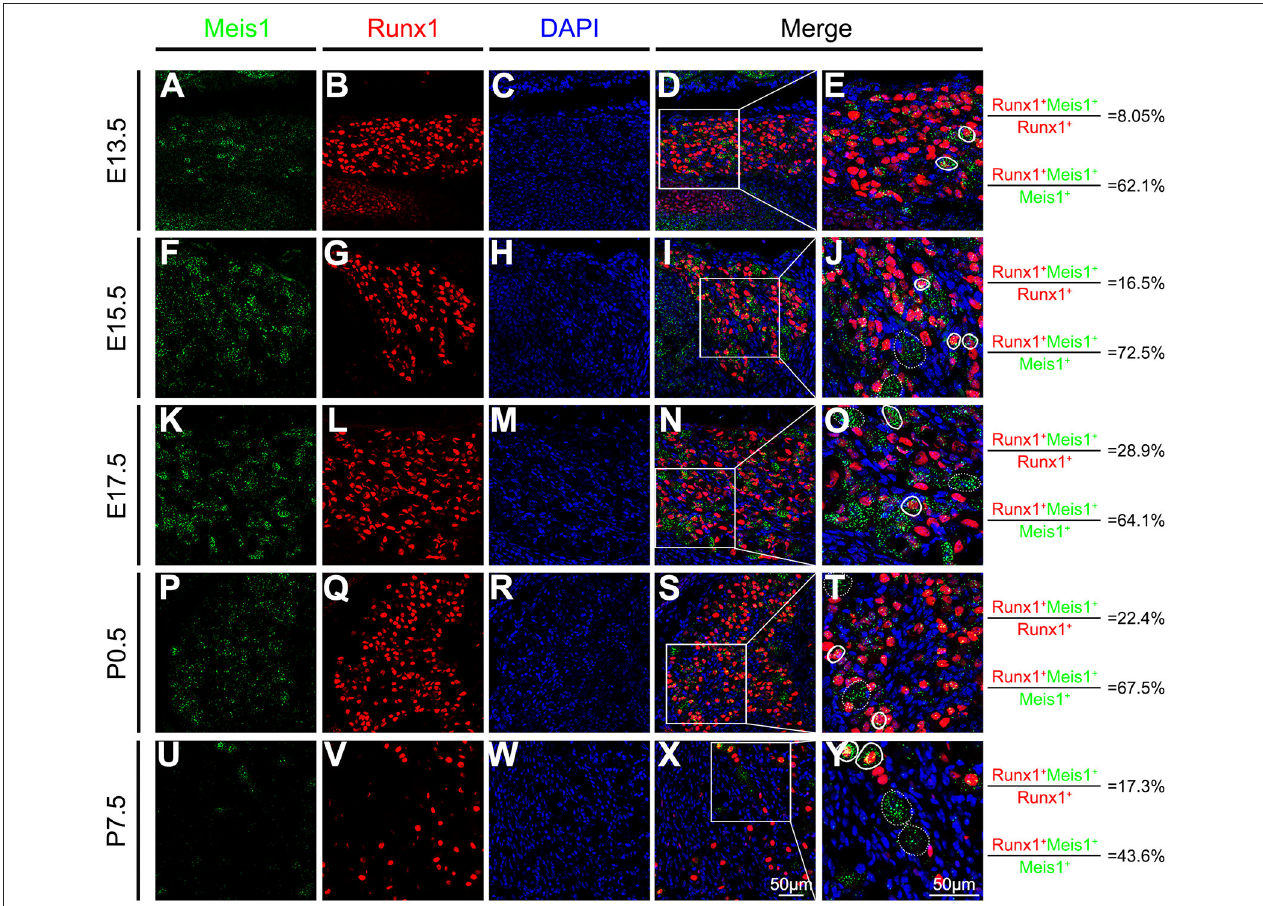
FIGURE 1 | Meis1 expression pattern in the DRG at different stages. Representative images of lumbar DRG sections costained with an antibody against the Runx1 protein (red) and Meis1 mRNA (green) in wild-type animals at E13.5 (A–E) , E15.5 (F–J) , E17.5 (K–O) , P0.5 (P–T) , and P7.5 (U–Y) . Note that 8.05% (379/4711), 16.5% (367/2219), 28.9% (954/3306), 22.4% (684/3052) and 17.3% (370/2142) of Runx1 + neurons coexpressed Meis1 at E13.5, E15.5, E17.5, P0.5 and P7.5, respectively. Additionally, 62.1% (379/610), 72.5% (367/506), 64.1% (954/1489), 67.5% (684/1013) and 43.6% (370/848) of Meis1 + neurons colocalized with Runx1 at E13.5, E15.5, E17.5, P0.5 and P7.5, respectively. (E,J,O,T,Y) Higher magnification views of the images shown in (D,I,N,S,X) . Solid lines indicate Meis1 + neurons coexpressing Runx1. Meis1 was expressed in large neurons indicated with a dotted line. DAPI-stained cell nuclei appeared blue. Quantitative data are shown to the right of the panels. Scale bar: 50 µ